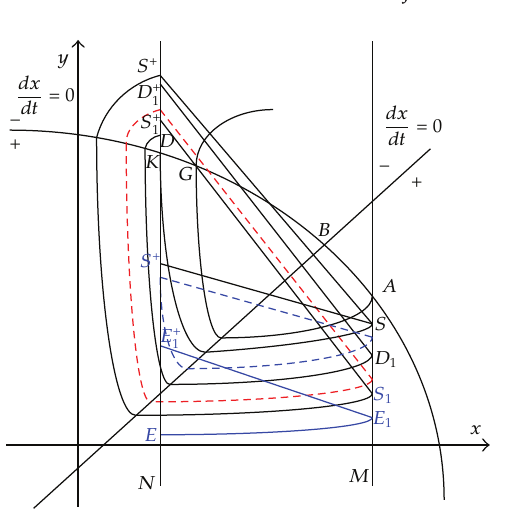
Figure 6: Illustration of system (cid:6) 1.3 (cid:7) for the case h > x ∗ , (cid:6) 1 − p (cid:7) h < x ∗ , x G > (cid:6) 1 − p (cid:7) h